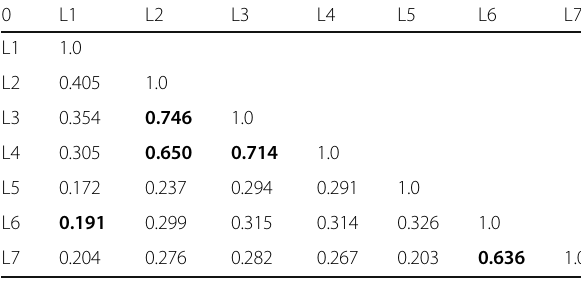
Table 9 Genetic similarity percentages for the seven